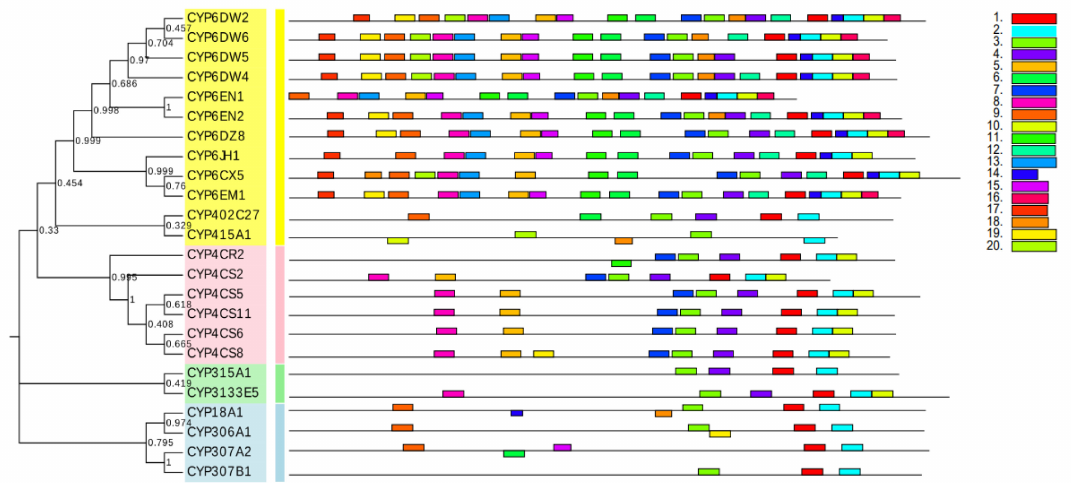
Figure 2. Phylogenetic relationships and protein motif analysis of Bemisia tabaci MED CYP. The unrooted phylogenetic tree was constructed using MEGA 7 by the neighbor-joining method and the bootstrap test was performed with 1000 replicates. The colored shadow marks the different CYP families. All motifs were identified by MEME database with the complete amino acid sequences of CYPs. Lengths of motifs for each CYP protein are exhibited